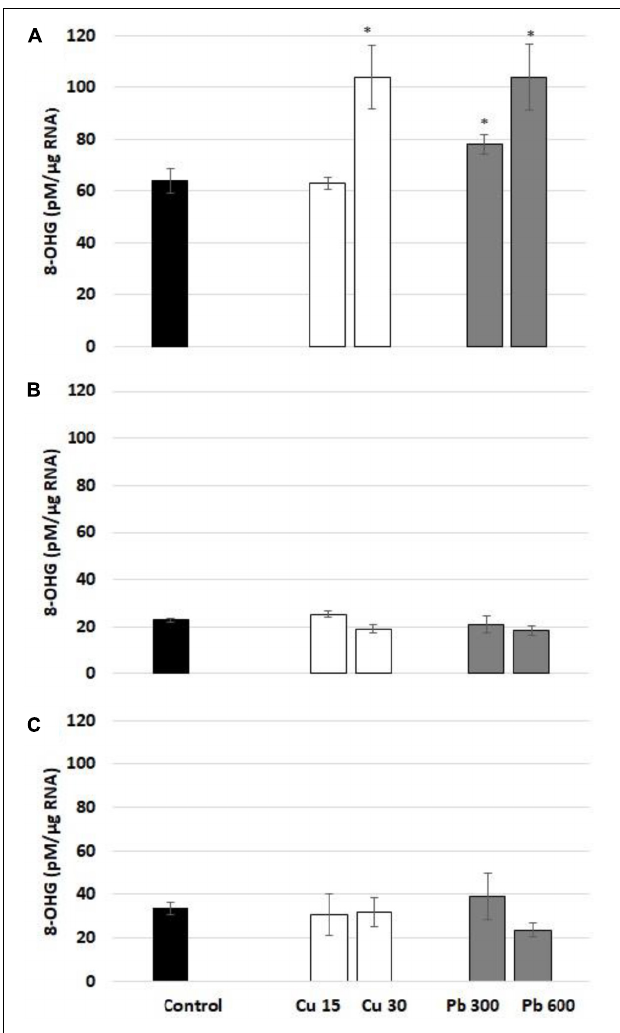
FIGURE 3 | The level of 8-OHG in RNA after 1 (A) , 3 (B) , and 24 h (C) . In the roots of control (black bar) soybean seedlings and the roots of soybean seedling exposed to Cu at concentrations 15 and 30 mg/l (white bars) and Pb at concentrations 300 and 600 mg/l (gray bars). The results are means of 3–4 experimental repetitions ± standard error. The statistically significant differences in relation to the control are marked with asterisk